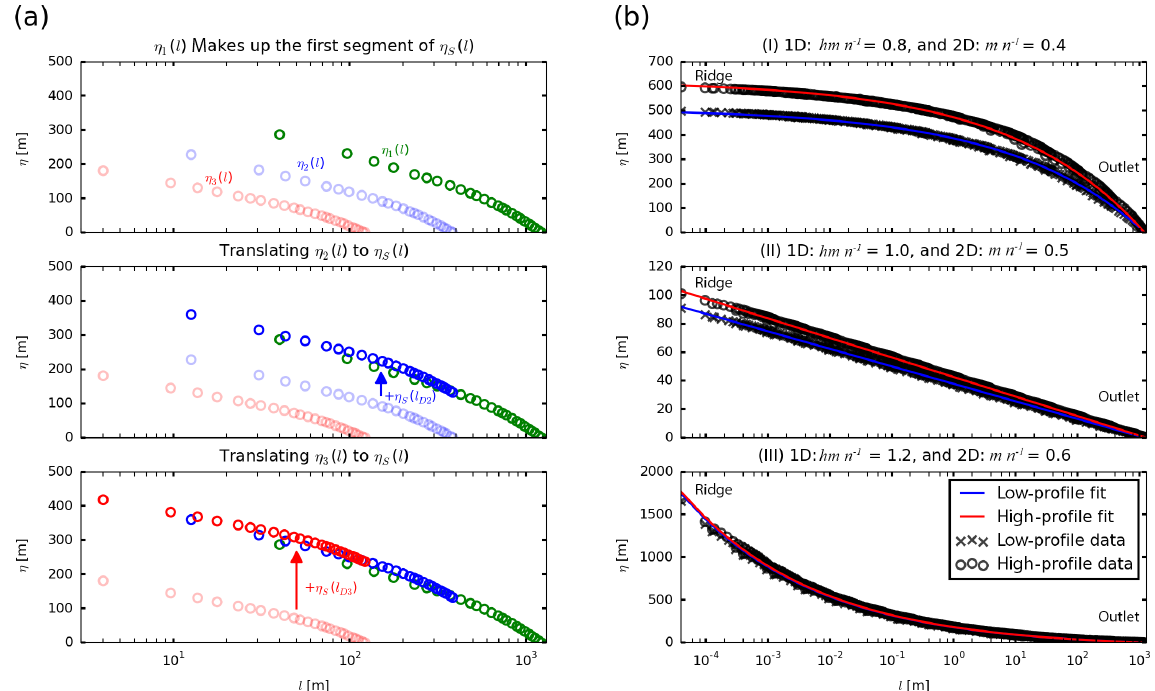
Figure 5. (a) Construction of the synthetic profile, η S ( l ). The opaque points represent the synthetic profile, and the transparent points represent the untranslated profiles. The green points represent the profile for i = 1, blue represents i = 2, and red represents i = 3. After η 13 ( l ) has been utilized in η S ( l ), the synthetic profile is complete. (b) One-dimensional steady-state equilibrium analytical solutions fitted to 2-D numerical results using P 1-D . Each m/n ratio contains two profiles: one generated from a flow path from the highest point on the ridge corresponding to the basin divide (HP) and one from the lowest point on the basin divide (LP). The circles (HP) and crosses (LP) represent the 2-D model data, and the red (HP) and blue (LP) lines represent the 1-D analytical model. For each m/n ratio, υ = 3mmyr − 1 , M 2 = 25 2 cells, = 10 − 6 to 10 6 km 2 . (I) Using K = 5.00 × 10 − 12 m 0 . 2 s − 1 , m/n = 0.4 (2-D), and hm/n = 0.8 (1-D), P n = 1.0, and L 2 2-D (LP) and P 1-D = 7.89 × 10 21 (HP). (II) Using K = 2.83 × 10 − 11 s − 1 , m/n = 0.5 (2-D), and hm/n = 1.0 (1-D), P 1-D = 5.79 × 10 21 (LP) and P 1-D = 6.47 × 10 21 (HP). (III) Using K = 3.82 × 10 − 12 m − 0 . 2 s − 1 , m/n = 0.6 (2-D), and hm/n = 1.2 (1-D), P 1-D = 2.13 × 10 23 (LP) and P 1-D = 2.15 × 10 23